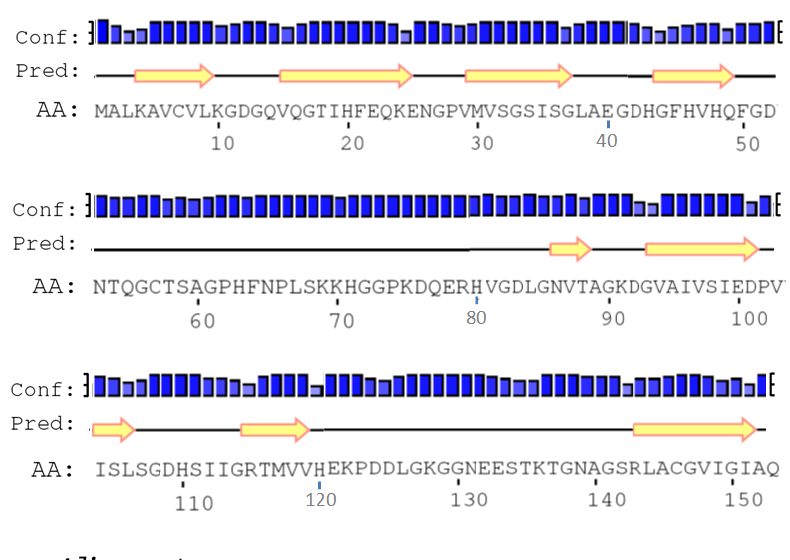
Figure 5. The secondary structure annotation sites of the cSOD1 sequence using PSIPRED program [35]. Yellow arrows indicated β